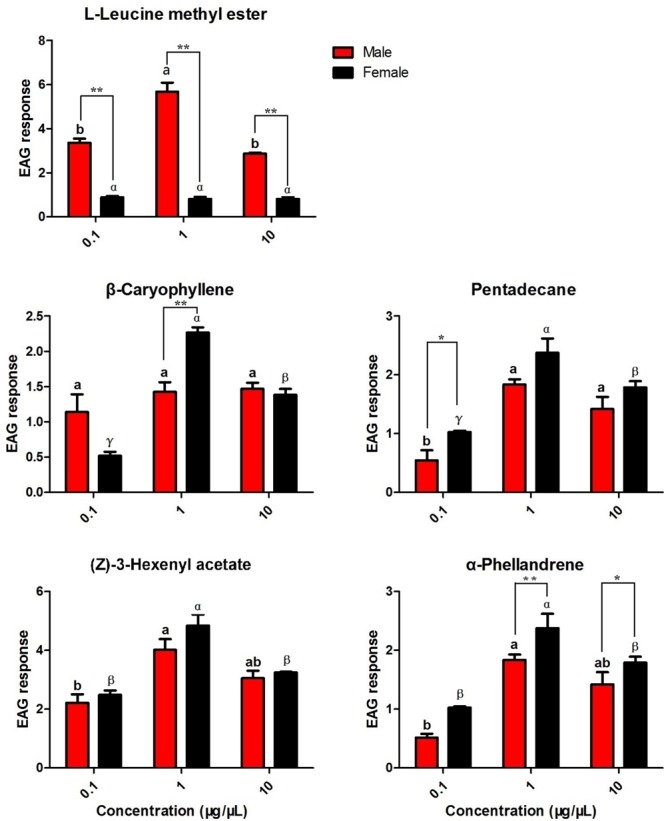
Electroantennogram (EAG) responses of male and female DBCs to host-associated volatiles and sex pheromone components. Mean ± SE (N= 6) after correction of the EAG with methanol. Significant differences between different chemicals were analysed through one-way analysis of variance (ANOVA) at a significance level of P < 0.05, and significant differences are indicated with different letters: a and b indicate males, and α, β, and γ indicated females. Asterisks indicate statistically significant differences between females and males (by Student’s t-test): ∗P < 0.05, ∗∗P < 0.01.